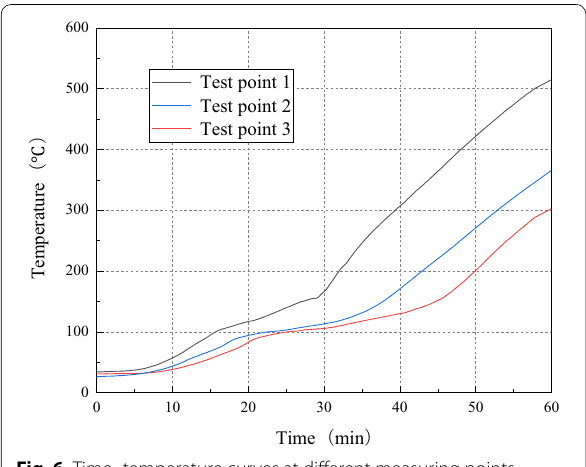
Fig. 6 Time–temperature curves at different measuring